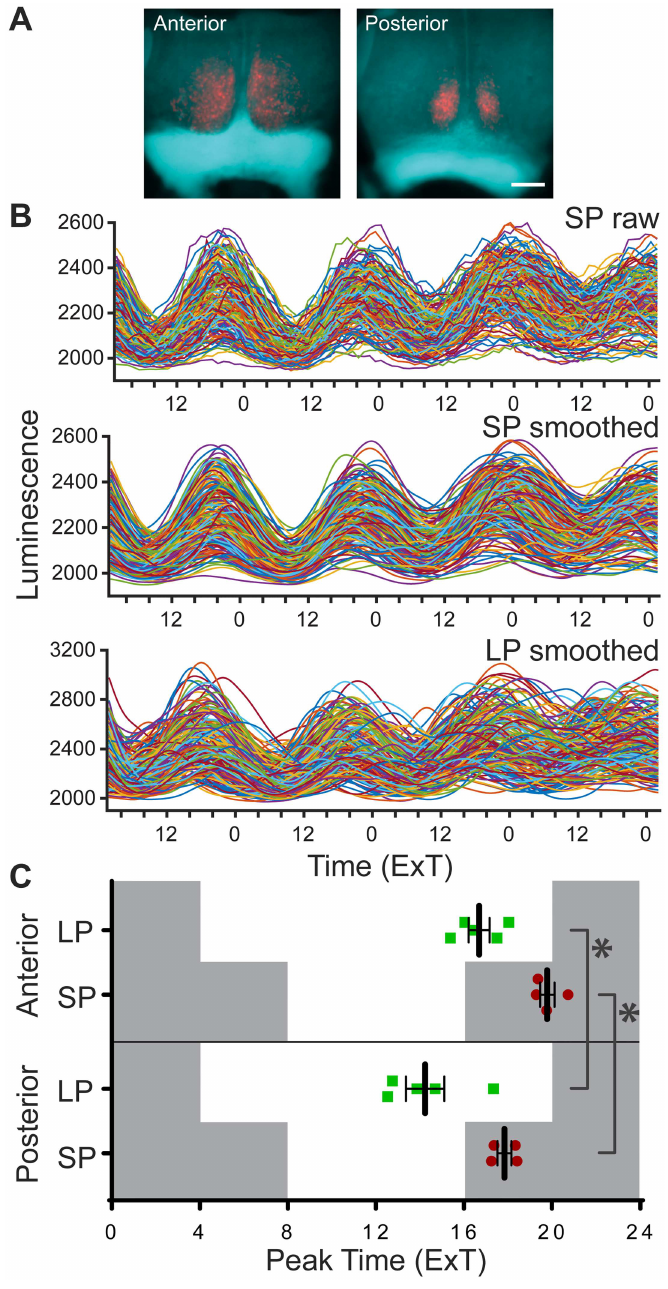
Fig 1. Peak time of PER2::LUC expression is similar in anterior and posterior SCN in both long and short photoperiod. (A) Overlays of brightfieldimages of anterior SCN cultures from short (SP) and long photoperiod (LP), with the corresponding bioluminescence image. Scale bar: 200 μ m. (B) Intensity traces of PER2::LUC expressionfrom single cells. Raw traces of bioluminescence intensity from the anterior SCN from SP ( n = 183 cells; top panel), with corresponding smoothedtraces (middle panel), and smoothedtraces from the anterior SCN from LP ( n = 177 cells; bottom panel). (C) Average peak time of PER2::LUCrhythms per slice, of the anterior and posterior SCN in LP (green squares, n = 5) and SP (red circles, n = 4) are plotted as externaltime (ExT). Grey background indicatesprojected dark periodof light regime preceding the experiment. Black bars indicatemean ± SEM; * p <